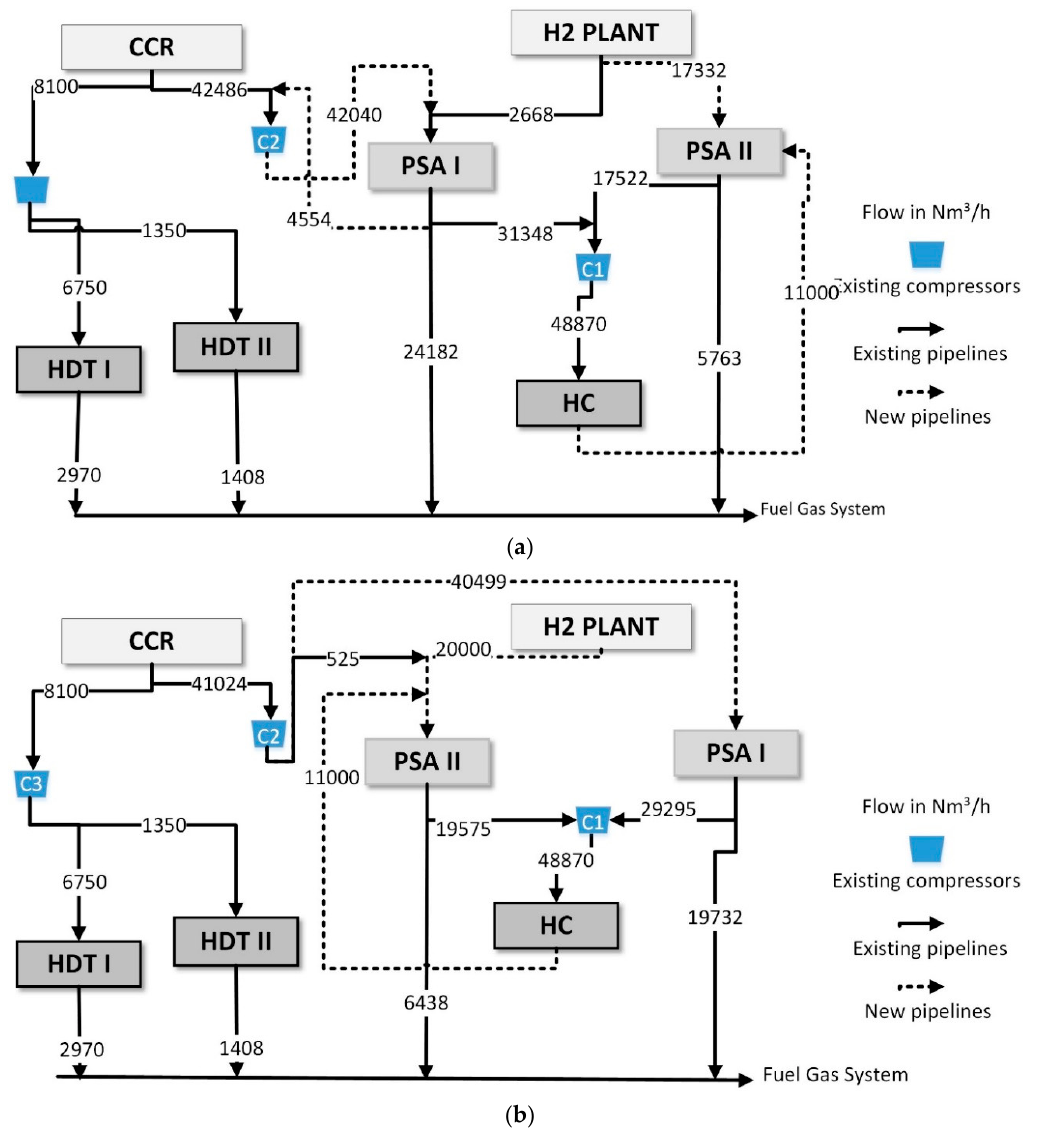
Figure 9. ( a ) Optimized network HN6 via HNS NLM for Example 2. ( b ) Optimized network HN7 via HNS NLM with HNS LM as initialization for example 2.